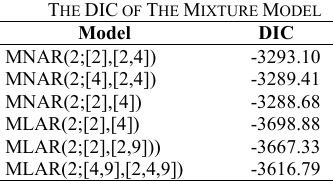
TABLE 3 T HE DIC OF T HE M IXTURE M